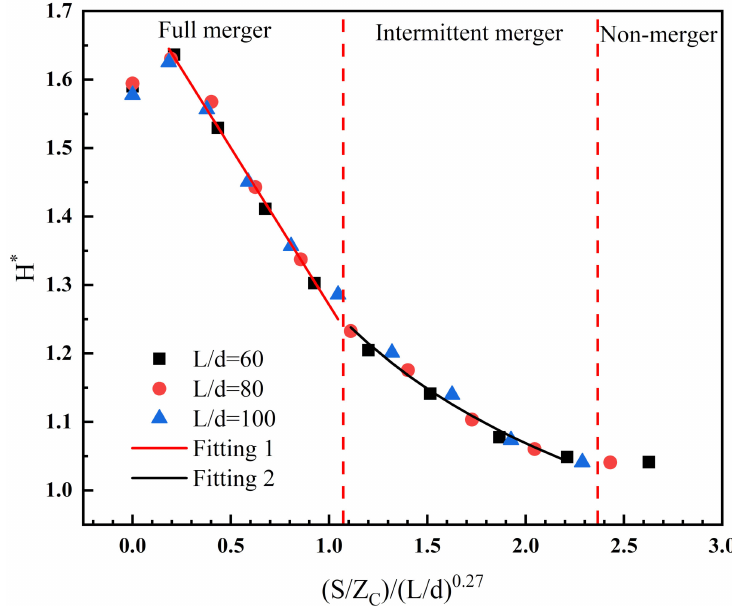
Figure 11. The relationship between dimensionless flame height H ∗ and (S/Z C )/(L/d) 0.27